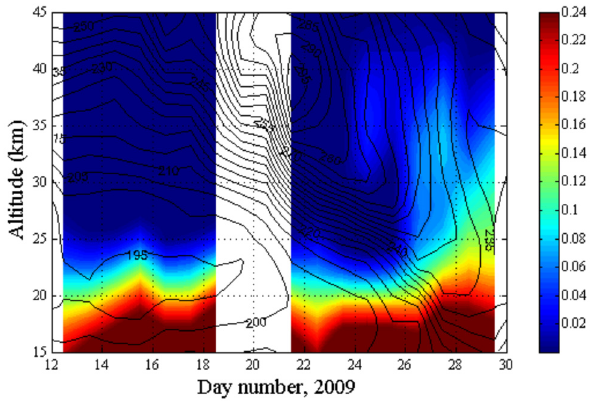
O vmr (in color, units of 2